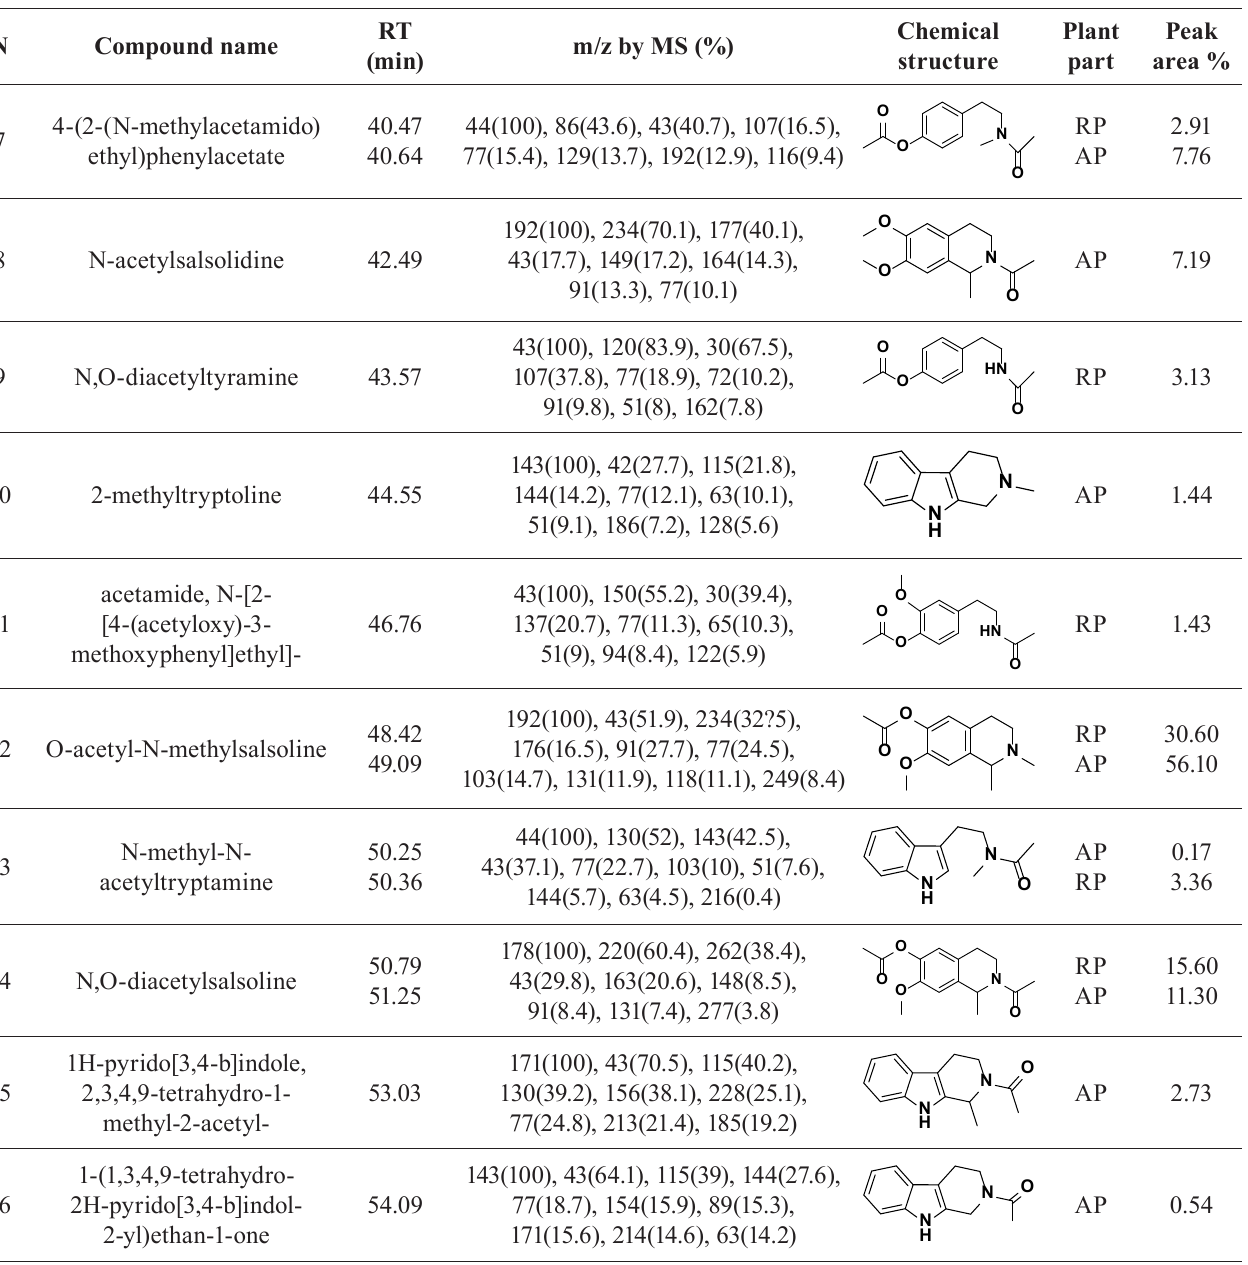
TABLE II - Chemical composition of the acetylated alkaloids extracts (ExAl (2)) obtained in the aerial part (AP) and the root part (RP) of Haloxylon scoparium by the second extraction protocol